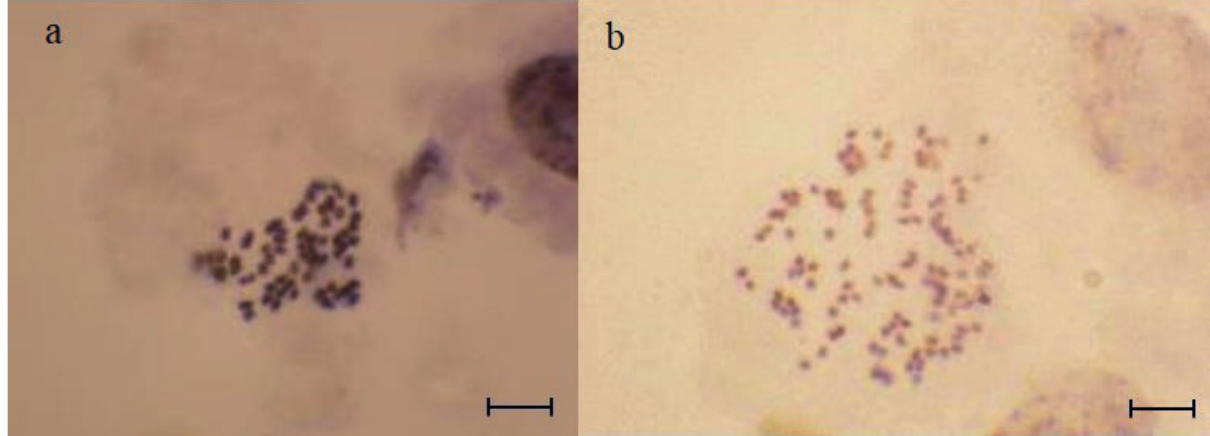
Figure 3. Chromosome numbers of S. mutica . Tetraploid control plant (2 n = 4 x = 60) (a) Octaploid plant (2 n = 8 x = 120) (b). Bars = 5